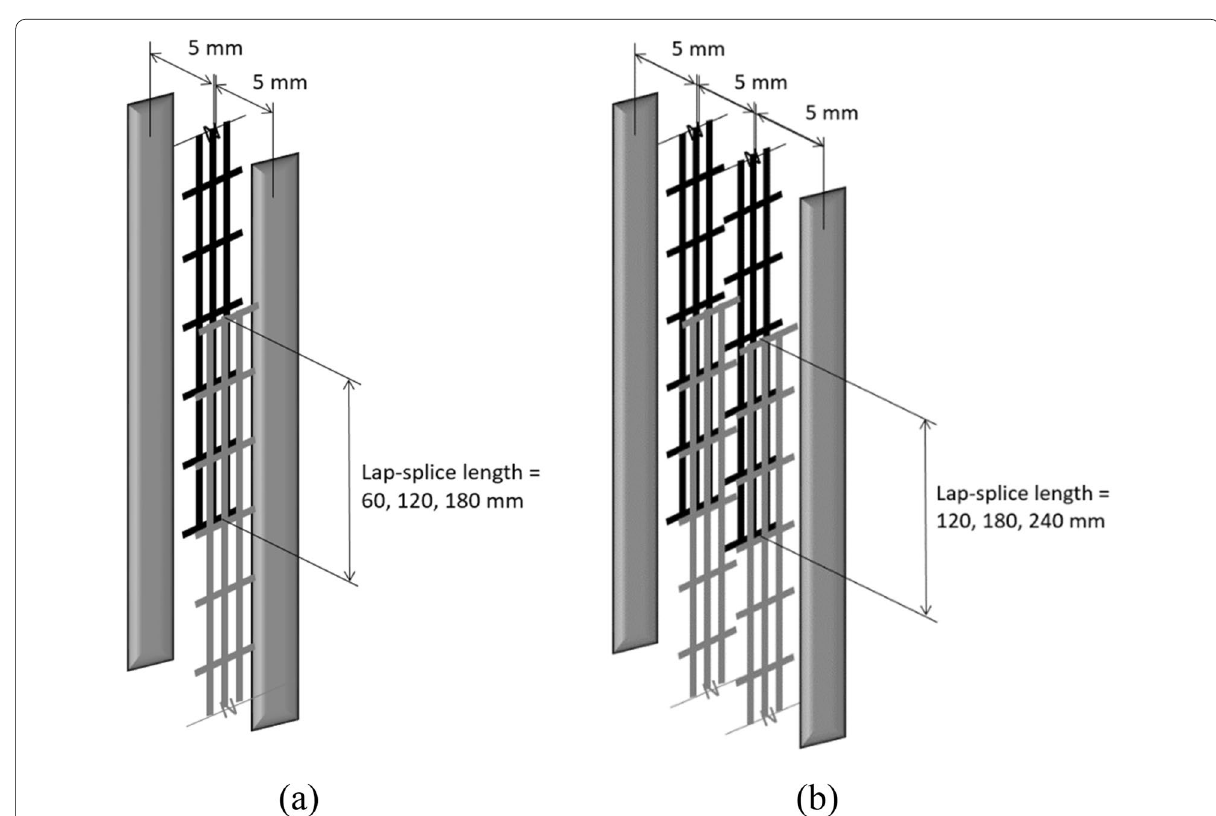
Fig. 4 Lap-splice test specimen: a single lap-splice, b double